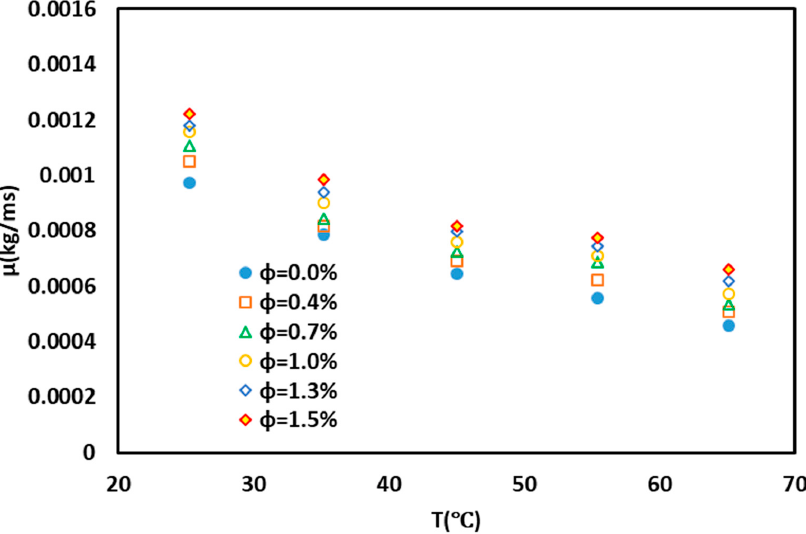
Figure 7. Viscosity variations of nanofluid with temperature and nanoparticle concentrations.